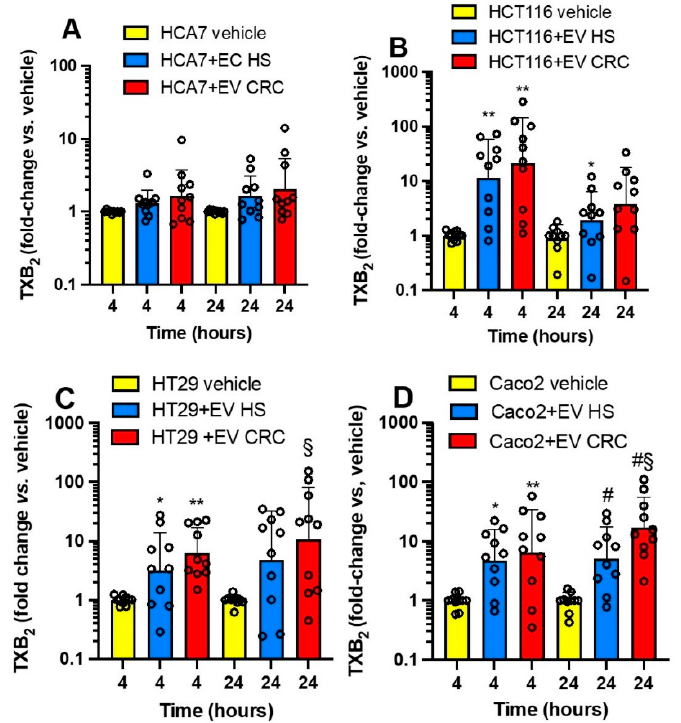
Figure 8. Effects of platelet-derived mEVs on TXB 2 generation in cocultures with cancer cells. Cancer cells (0.5 × 10 6 ), ( A ) (HCA7 cells), ( B ) (HCT116 cells), ( C ) (HT29 cells), ( D ) (Caco2 cells) were incubated for 4 and 24 h with EVs from CRC or HS individuals (100 µ g), and TXB 2 levels were assessed by immunoassay and reported as fold-change vs. values detected in the conditioned medium of cancer cells cultured alone. The values were not normally distributed and were transformed to logarithms, and all values are shown as scatter dot plots with mean + SD, n = 10, and analyzed by one-way ANOVA followed by Tukey’s multiple comparisons test. ( B ) 4 h, ** p < 0.01 vs. vehicle; 24 h, * p < 0.05 vs. vehicle. ( C ) 4 h, * p < 0.05, ** p < 0.01 vs. vehicle; 24 h, § p < 0.01 vs. vehicle. ( D ) 4 h, * p < 0.05, ** p < 0.01 vs. vehicle; 24 h, # p < 0.01 vs. vehicle, § p < 0.05 vs. EV HS.